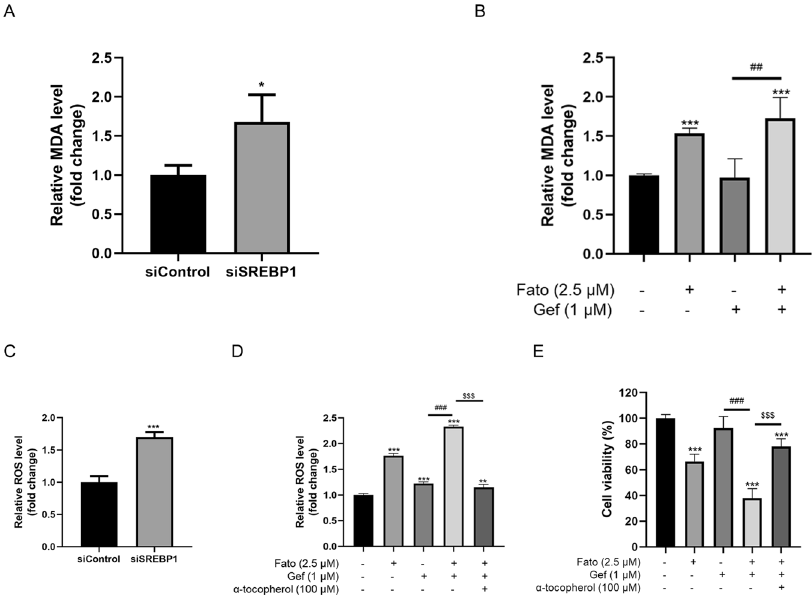
Fig. 4 Inhibition of SREBP1 affects lipid peroxidation and oxidative stress in PC9/GR cells. PC9/GR cells transfected with siRNA or were treated with ge fi tinib in the presence or absence of Fato (2.5 μ M) and α -tocopherol (100 μ M) for 72 h. A , B Intracellular MDA content measurement of PC9/GR cells. C , D ROS concentration of PC9/GR cells were measured. E Cell viability was measured by CCK8. Data are expressed as the mean ± SD ( n = 4). *P < 0.05, **P < 0.01, ***P < 0.001 compared with control. # P < 0.05, ## P < 0.01, ### P < 0.001 compared with ge fi tinib. $$$ P < 0.001 compared with Gef +